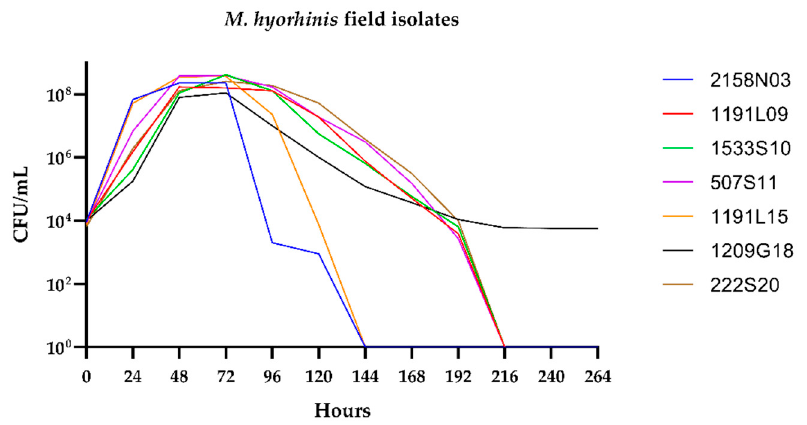
Figure 4. Growth curves of seven M. hyorhinis field isolates cultured in modified Friis broth for eleven days.